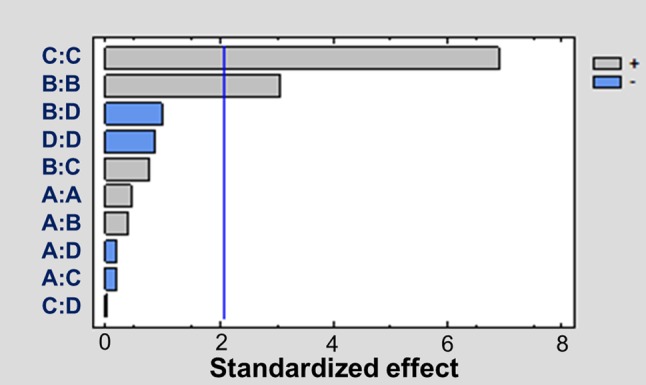
Pareto chart of the standardized effect for AfB1 adsorption. A is the pH, B is the adsorbent mass, C is the mycotoxin concentration, and D is the time. The effect of one factor is statistically significant (p < 0.05) if its absolute value is higher than 2.3 (sector of the chart at the right of the vertical line).